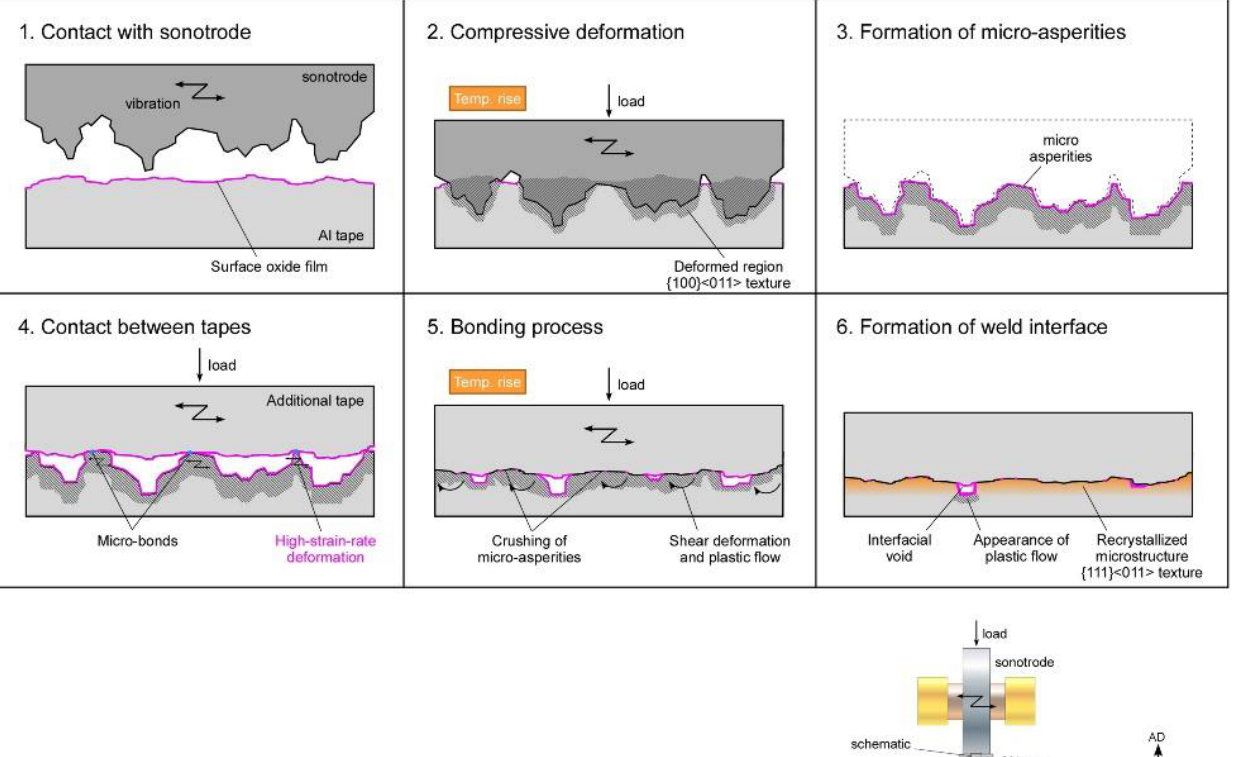
Figure 15. Schematic representation of UAM process for welding [193].